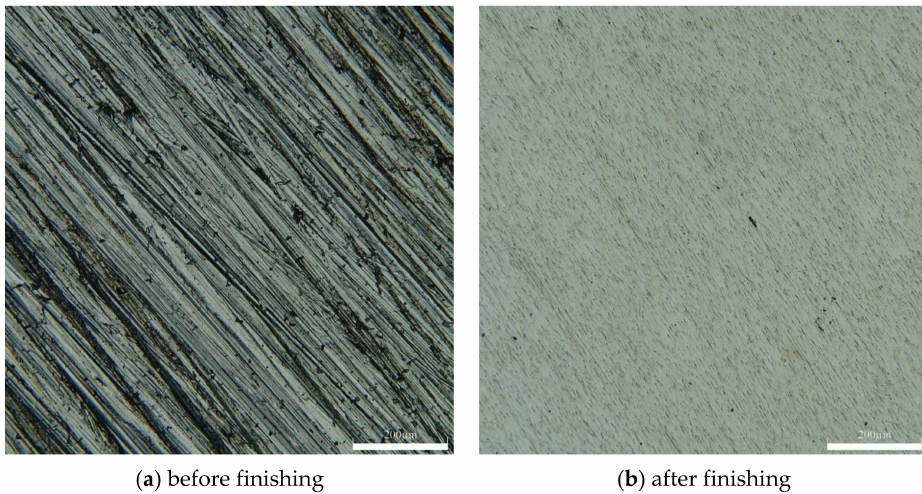
Figure 13. Microscopic morphology map of the material surface.